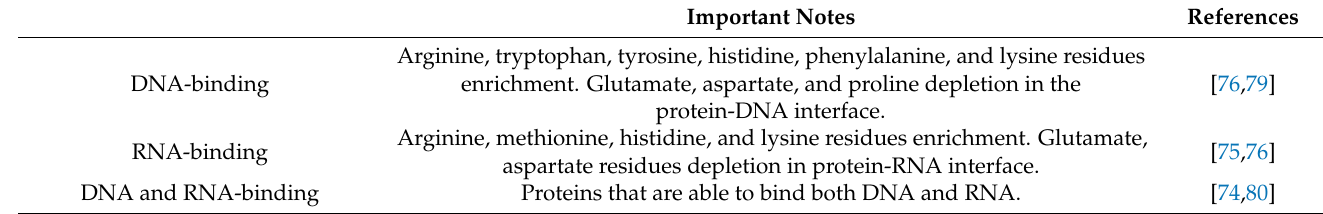
Table 1. Types of nucleic acid-binding proteins. This table summarizes the main categories of nucleic acid-binding proteins. There are two points of view. At first, we can simply divide these proteins into DNA and RNA-binding ones (and a relatively small category of proteins that are able to bind both DNA and RNA). Secondly (and more importantly), we can distinguish proteins that specifically bind known sequence motifs (sequence-specific DNA/RNA-binding) and proteins, which specifically bind local DNA/RNA structures. Besides, keep in mind that this table is very simplified, and categories are divided to be reader-friendly. In fact, many of the DNA/RNA-binding proteins combine sequence and structure-specific binding